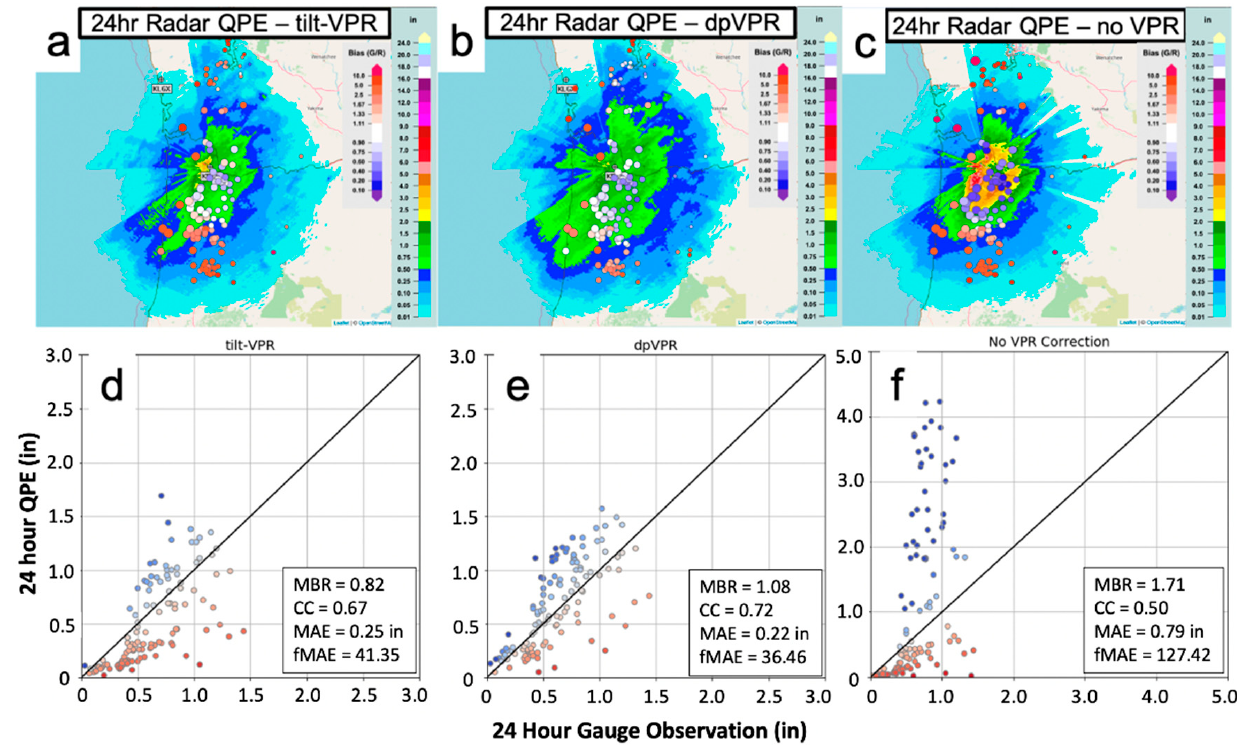
Figure 11. Twenty-four h radar QPEs from the KRTX WSR-88D radar ending at 15:00 UTC 07 February 2017 with ( a ) tilt-VPR, ( b ) dpVPR, and ( c ) no VPR correction and the corresponding scatter plots vs. CoCoRaHS gauges (panels ( d – f ), respectively). The Z = 210 R 1.46 relation is used.